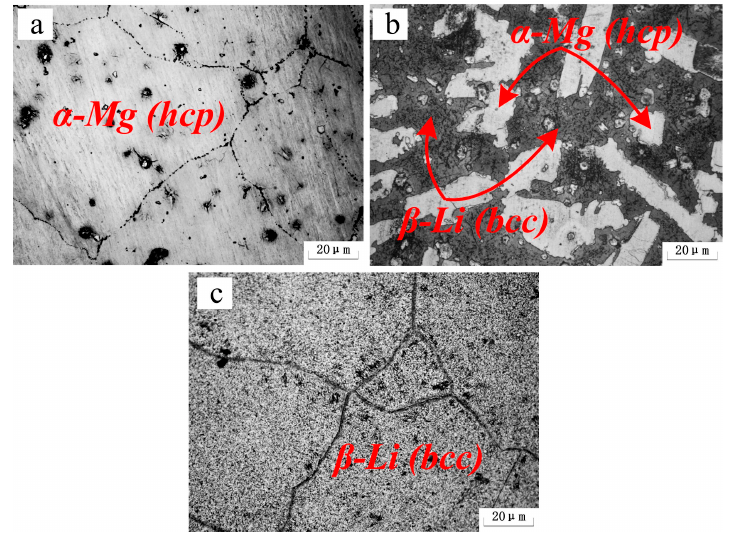
Figure 3. Microstructures of as-cast alloys: ( a ) Mg-5Li-3Al-2Zn-0.2Y; ( b ) Mg-8Li-3Al-2Zn-0.2Y; ( c ) Mg-11Li-3Al-2Zn-0.2Y.